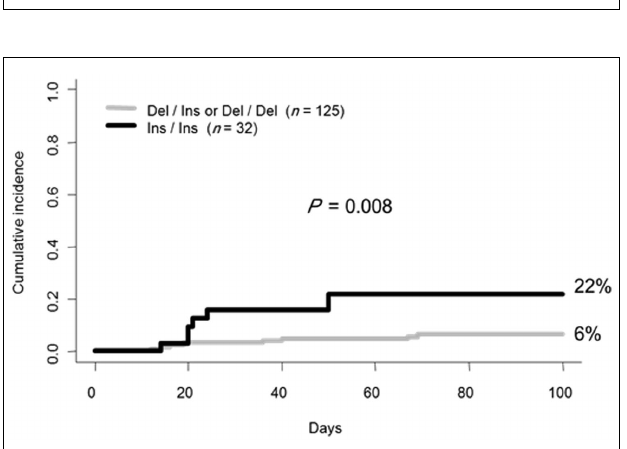
FIGURE 2 | Cumulative incidence for aGvHD based on HLA-G genotype in patients stratified for severity (grade 0, I, II versus III, IV).